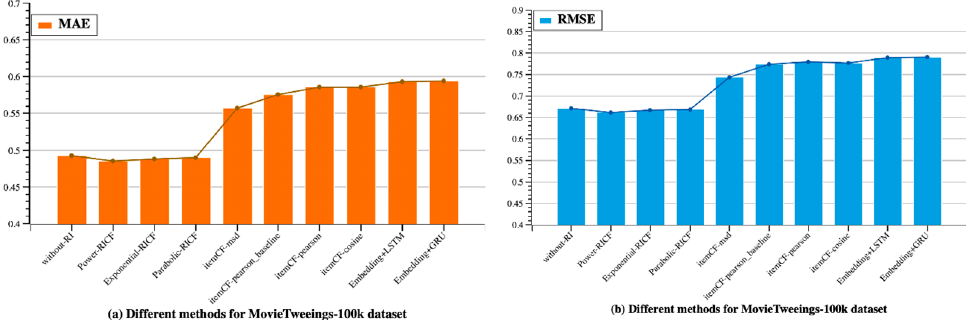
Figure 10. The evaluations of ten algorithms for MovieTweetings-100k dataset. ( a ) MAE metric; ( b ) RMSE metric.